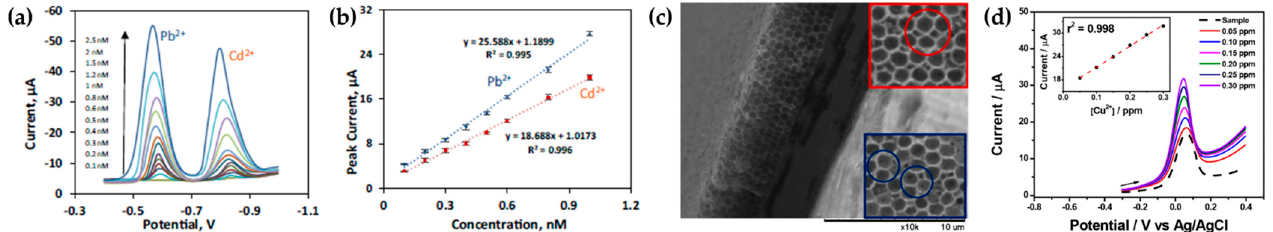
Figure 5. ( a ) DPASV voltammograms for the simultaneous analysis of Pb 2+ and Cd 2+ at the Ppy- CO 2 @PGE. ( b ) Calibration plots of Pb 2+ (blue circles) and Cd 2+ (red squares). Adapted from reference [83]. ( c ) SEM images of a cross-section of a highly ordered macroporous PXDOT electrode. Insets show a close-up of the gaps (red) and the interconnection points (blue). ( d ) SWASV for successive addition of Cu 2+ obtained with a macroporous PXDOT electrode in a 10% diluted mezcal solution. Inset shows a plot of peak current vs concentration of added copper. Adapted from reference [94].